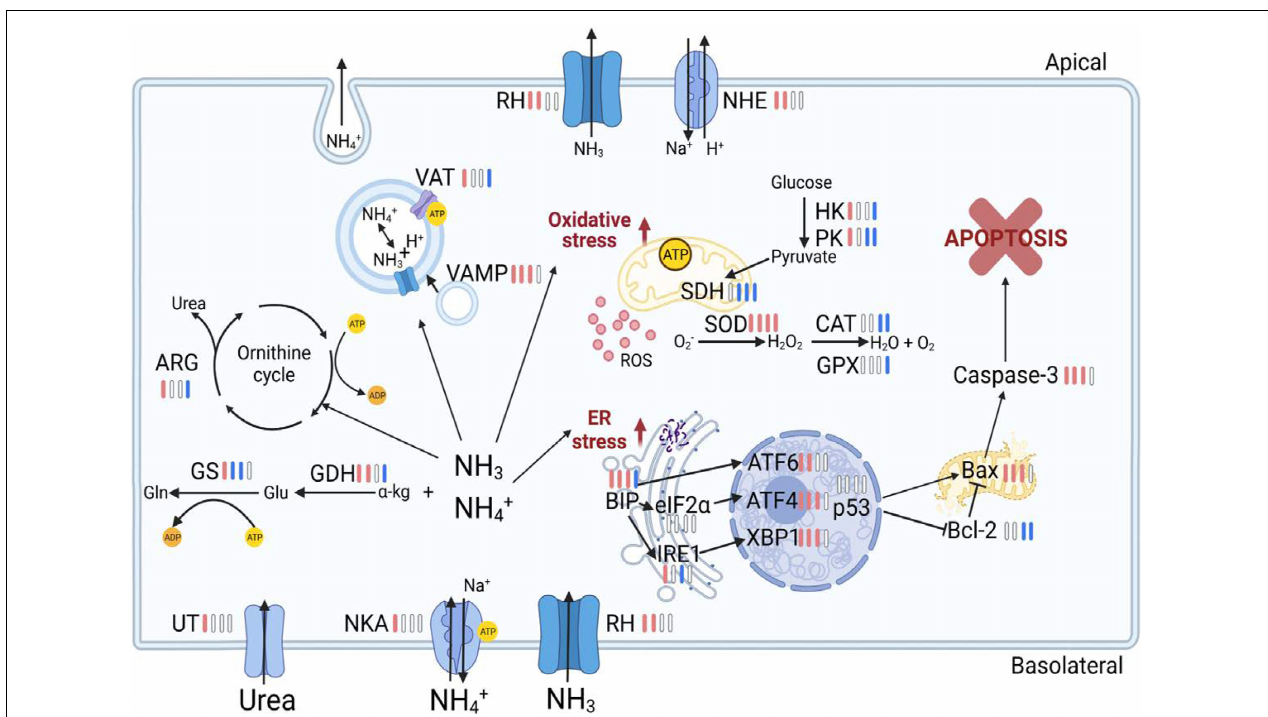
FIGURE 7 | Overview of physiological and molecular responses in the gill of the swimming crab Portunus trituberculatus during long-term ammonia stress. The different colors of the bars indicate the changes of physiological parameters and gene expression in HA group (8 mg l − 1 ). Red bars represent significant up-regulation, blue bars represent significant down-regulation and white bars represent no significant difference, compared with the control group. The figure is created in